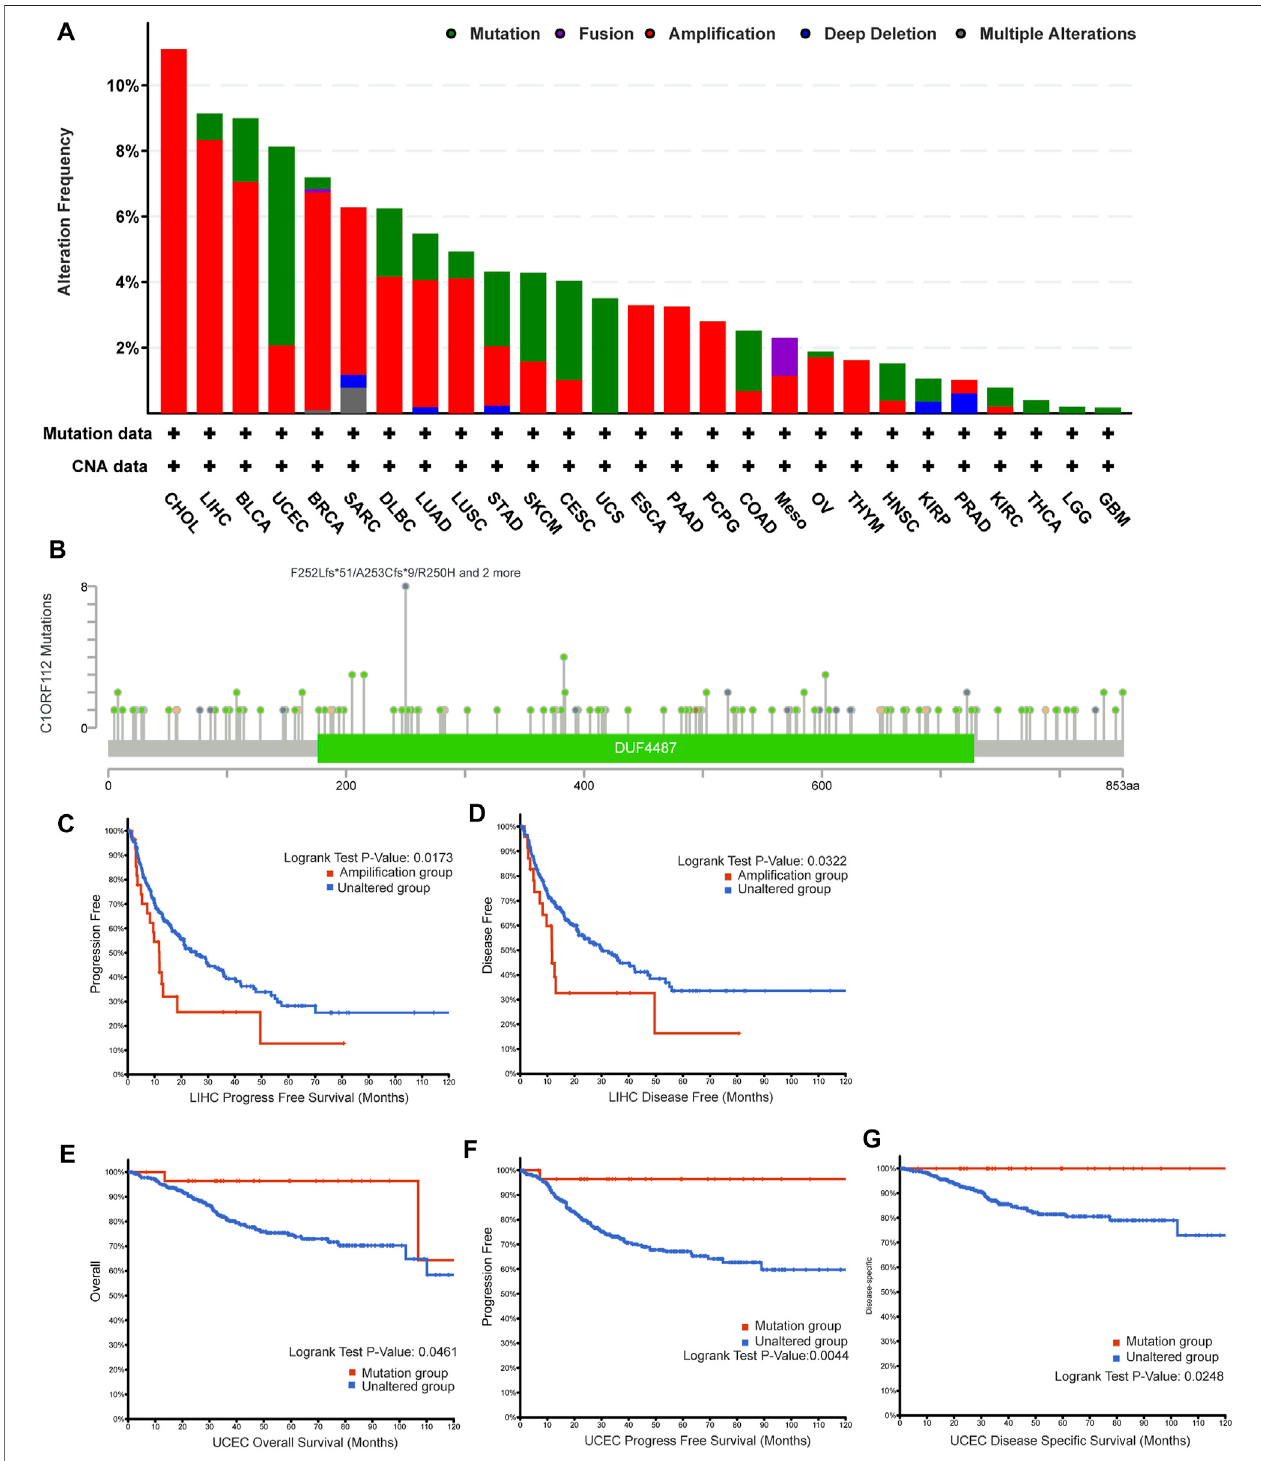
FIGURE 4 | C1ORF112 genetic alteration in various tumor types of TCGA. The alteration frequency with C1ORF112 genetic alteration type (A) and C1ORF112 mutationsite (B) weregeneratedbycBioPortal.Thecorrelationsbetween C1ORF112 ampli fi cationstatusandprogression-freesurvivalanddisease-freesurvivalofLIHC (C,D) wereanalyzedbycBioPortal.Thecorrelationsbetweenmutationstatusandoverallsurvival,progression-freesurvival,anddisease-speci fi csurvivalofUCEC (E – G) were analyzed by cBioPortal.